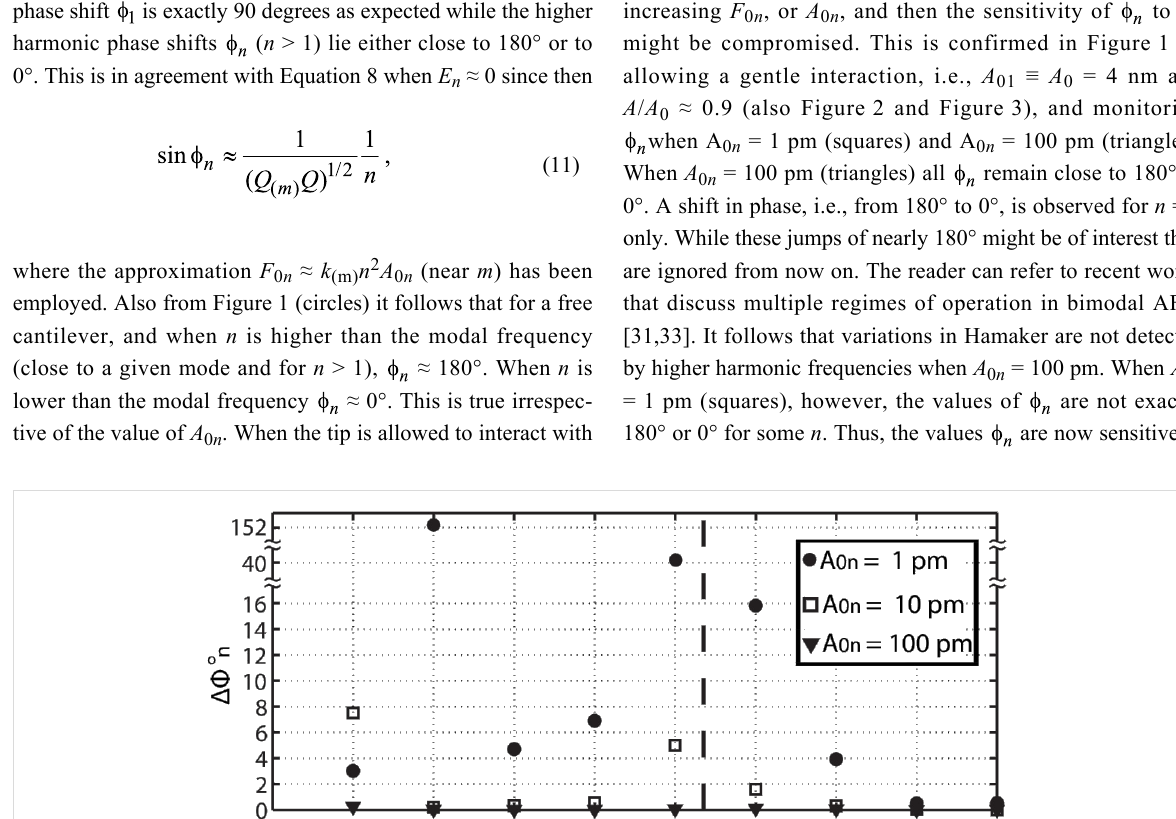
The actual harmonic amplitudes A n that resulted when inter- acting are not shown, instead A n ≈ A 0 n is given throughout. The case of a free cantilever (circles) shows that the fundamental phase shift is exactly 90 degrees as expected while the higher harmonic phase shifts ( n > 1) lie either close to 180° or to 0°. This is in agreement with Equation 8 when E n ≈ 0 since then